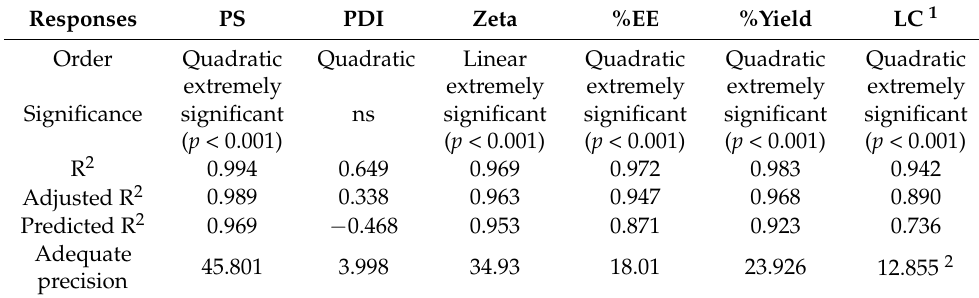
Table 1. Characteristics of the generated response surface